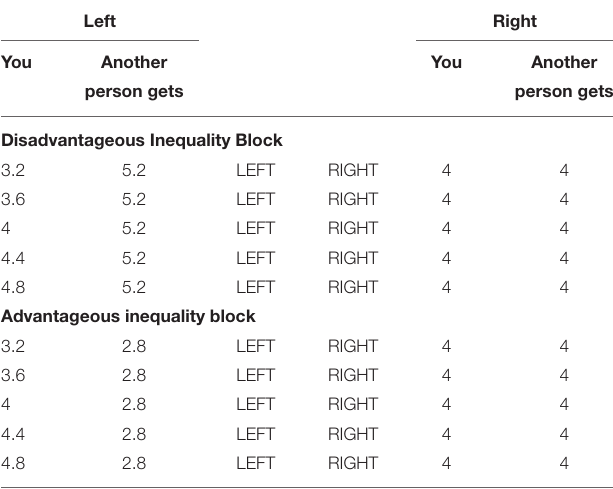
TABLE 2 | The equality equivalence test